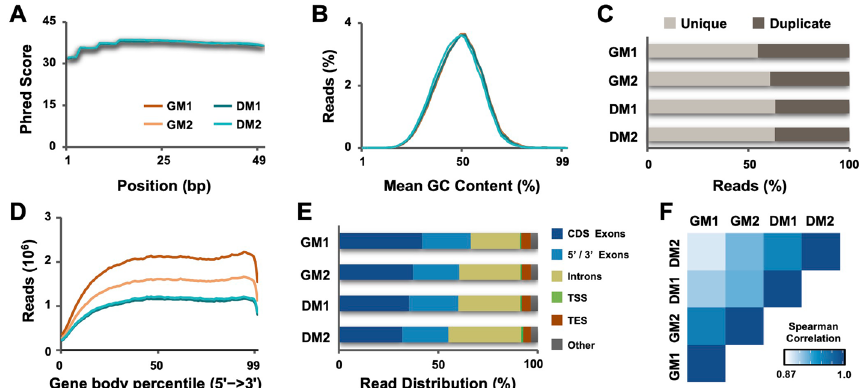
Fig. 2 Quality control of the RNA-seq datasets. A distribution of base quality scores is shown for two biological replicates of RNA-seq of C2C12 myoblasts following 24 h of differentiation (DM1, DM2) with proliferating myoblasts as controls (GM1, GM2). B The distribution of GC content across the reads. C The percentage of unique and duplicate reads from all mapped reads in each dataset. D The distribution of read coverage across the gene body. E The alignment of reads to known gene features in the reference genome (CDS, coding sequence; TSS, transcription start site; TES, transcription end site). F Heatmap of Spearman correlation coefficients calculated between log 2 - transformed, nonzero FPKM expression values in both replicates of proliferating and differentiating myoblasts